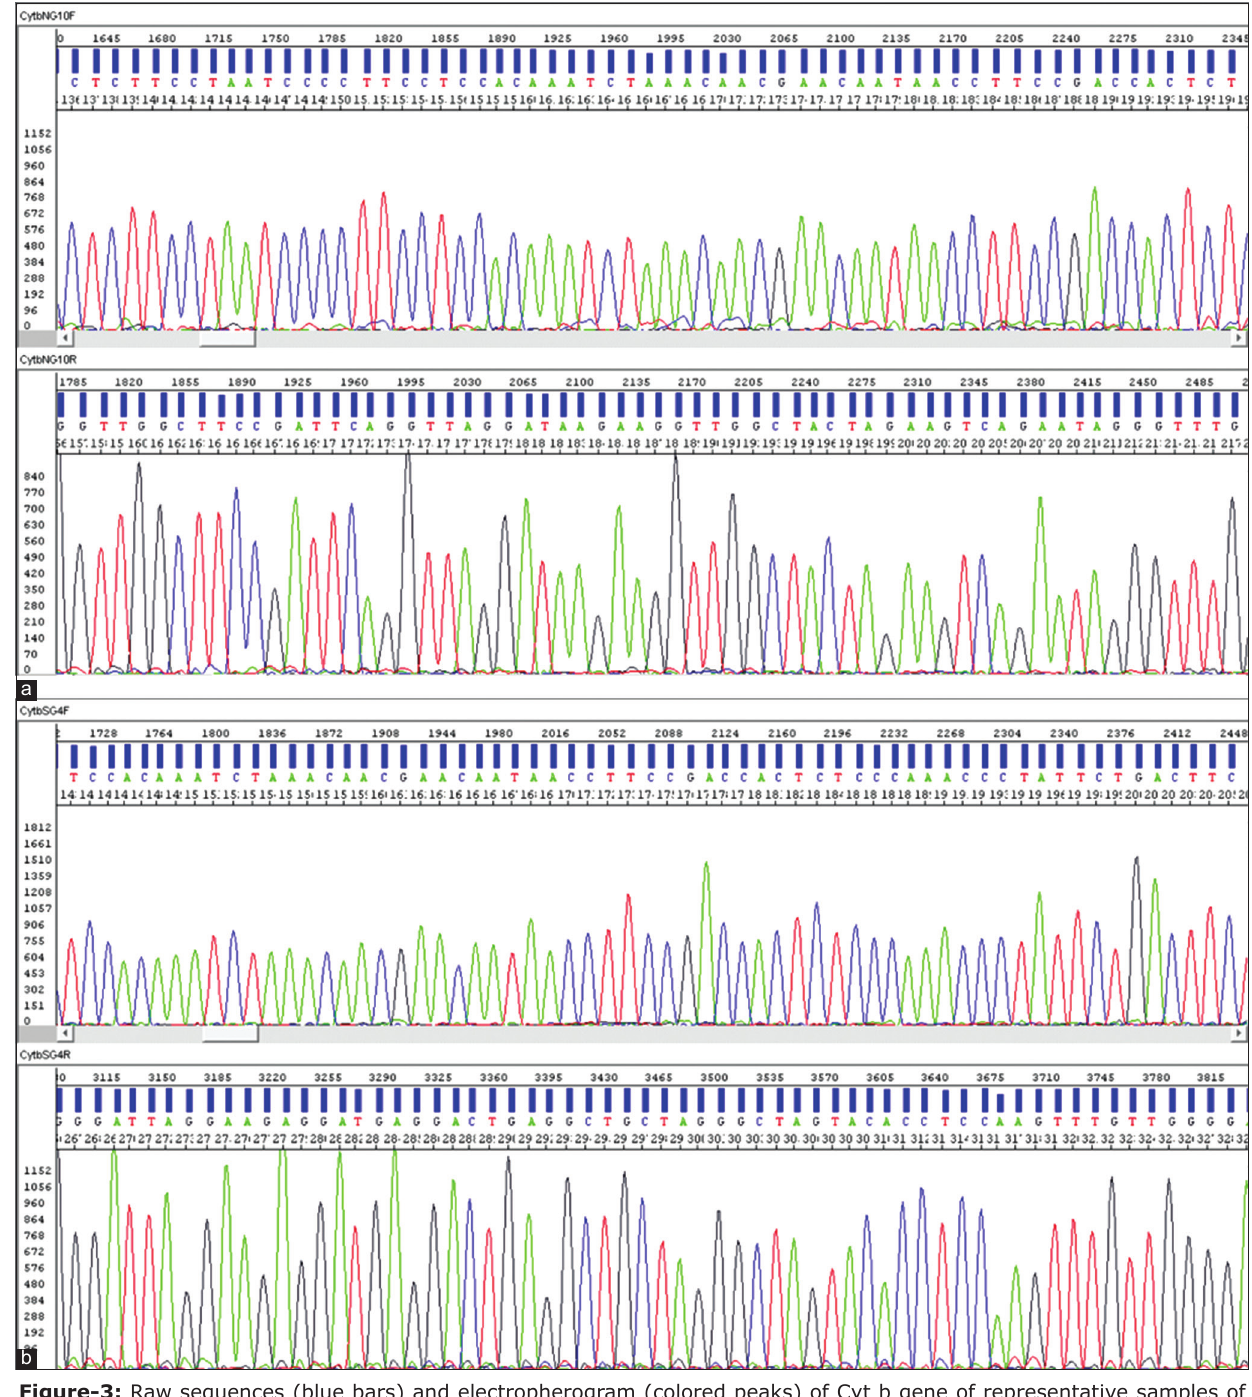
Figure-3: Raw sequences (blue bars) and electropherogram (colored peaks) of Cyt b gene of representative samples of Aravali (a) and Ankleshwar (b) population. (a) NG10 (b)